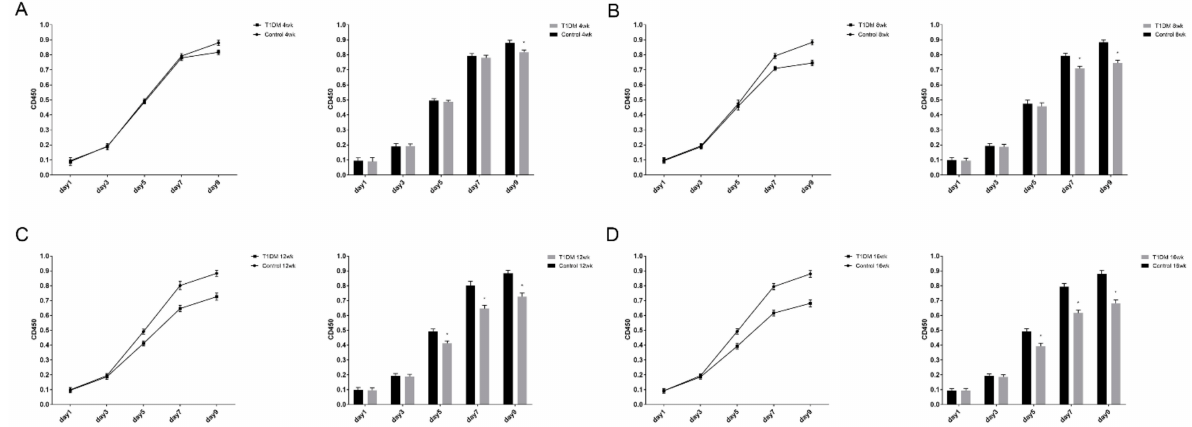
Figure 4. ASC proliferation. ( A ): At 4 weeks, proliferation decreased at day 9 compared with control groups of the same time point. *, p < 0.05. ( B ): At 8 weeks T1DM groups, proliferation diminished at day 7, day 9, compared with control groups. *, p < 0.05. ( C , D ): At 12 or 16weeks T1DM groups, proliferation lowered at day 5, day 7, day 9, compared with control groups. *, p <